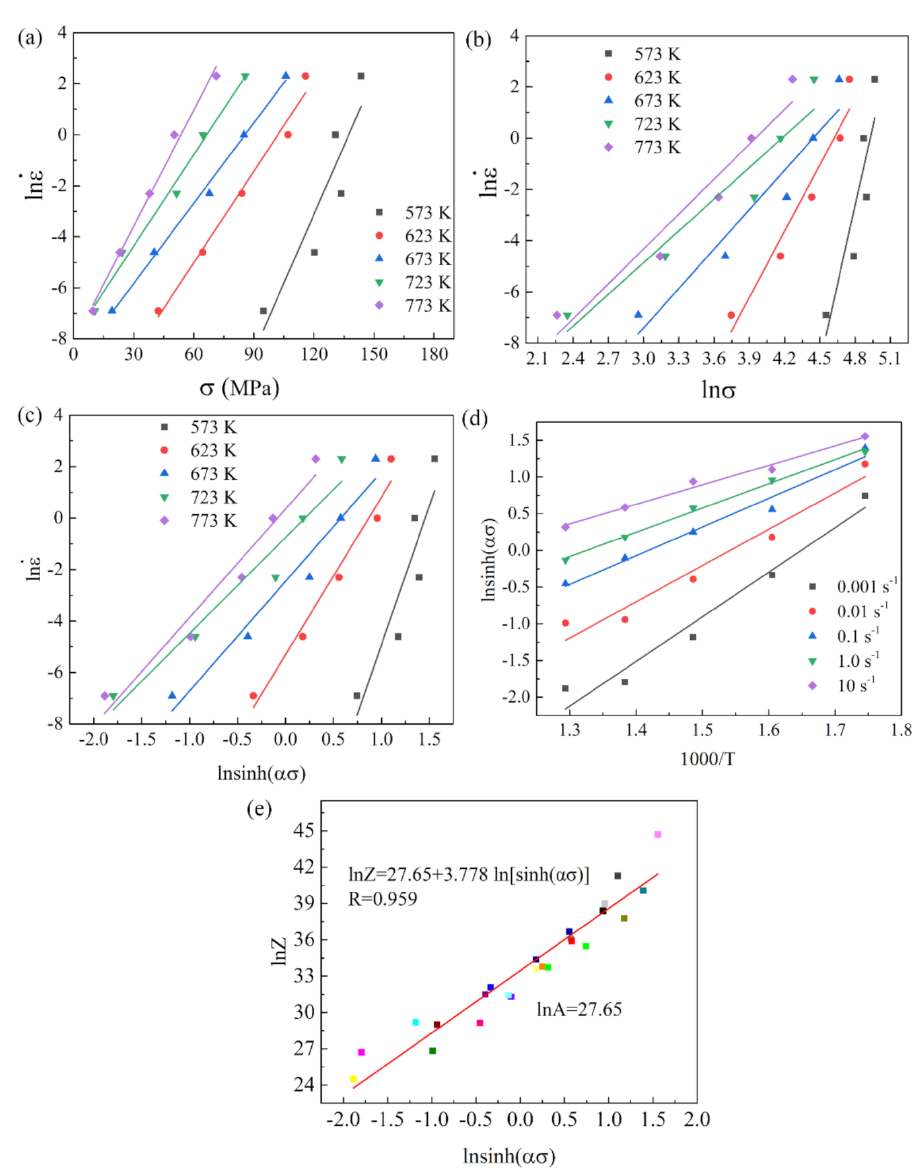
. . ε , ( b ) ln σ - ln ε , ( c ) ln[sinh( ασ )]-ln